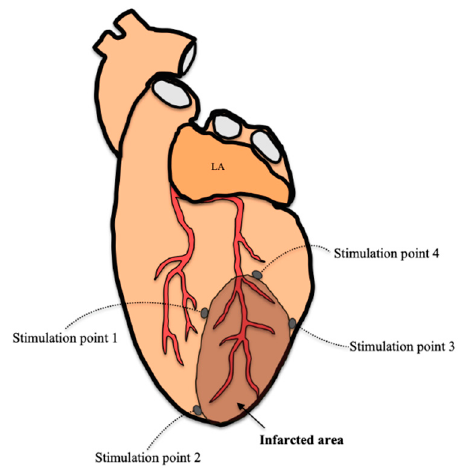
Figure 2. Schematic representation of the distribution of the four ventricular stimulation electrodes (stimulation point) located around the infarcted area. Abbreviations: LA: left atrium.